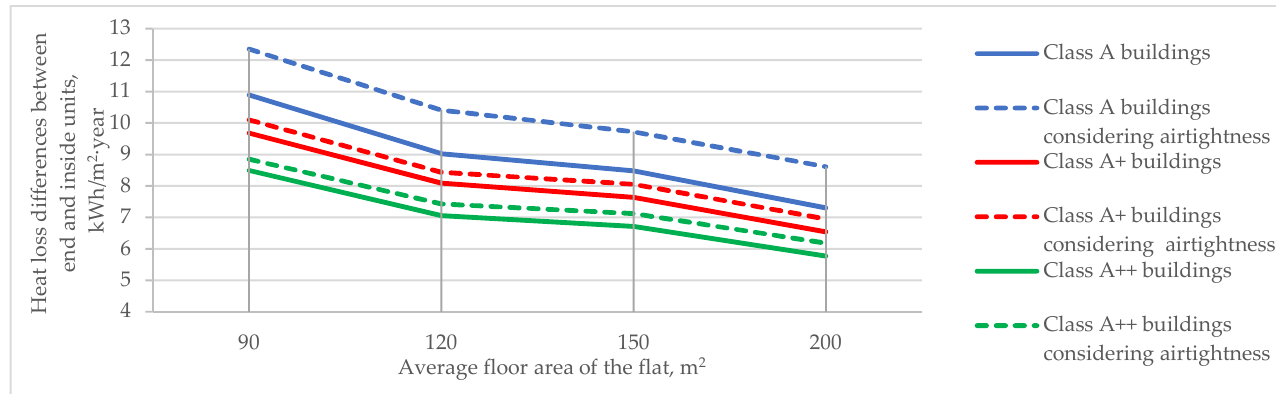
Figure 8. Heat loss differences reflecting the increase of values for end units in comparison with inside units. wall structure.